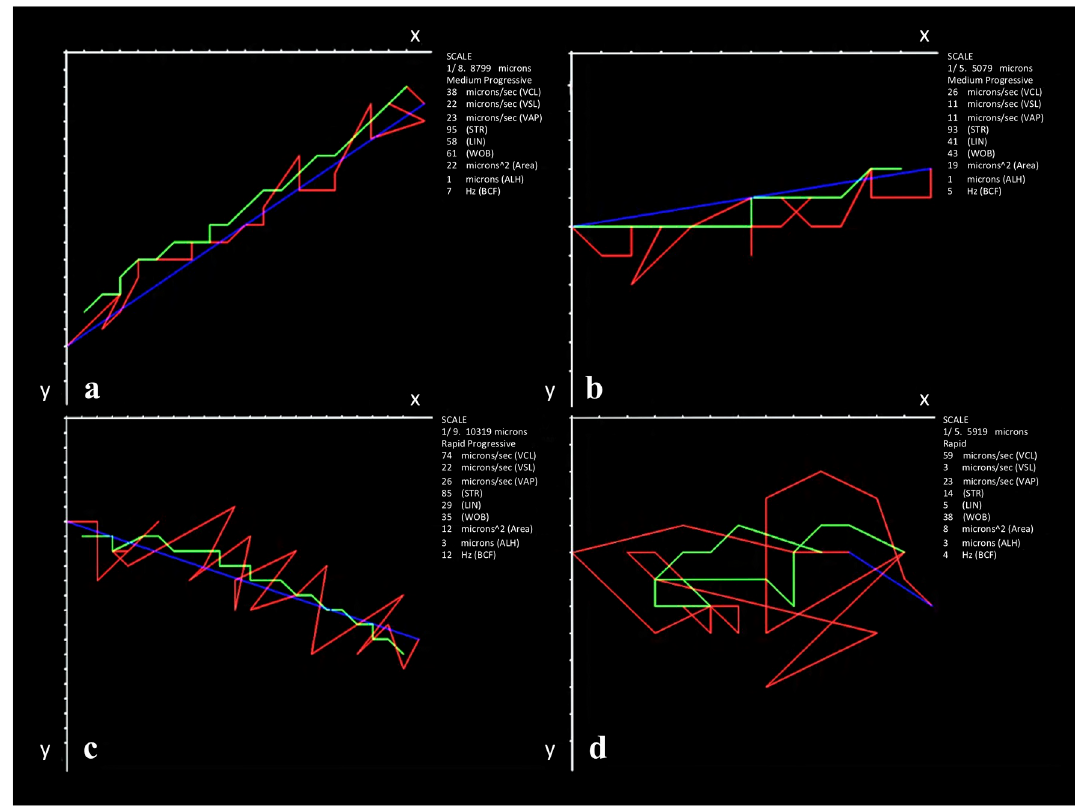
Fig 3. Representative trajectories by subpopulation of American crocodile ( Crocodylus acutus ) sperm analyzed with ISAS 1 v1 CASA-Mot system. a: Rapid progressive (SP1); b: Slow progressive (SP3); c: Medium non-progressive (SP4); d: Slow non-progressive (SP2). Lines: Blue = VSL; Red = VCL; Green = VAP. VCL = curvilinear velocity ( μ m / s); VSL = straight-line velocity ( μ m / s); VAP = average path velocity ( μ m / s). SP: Subpopulation.